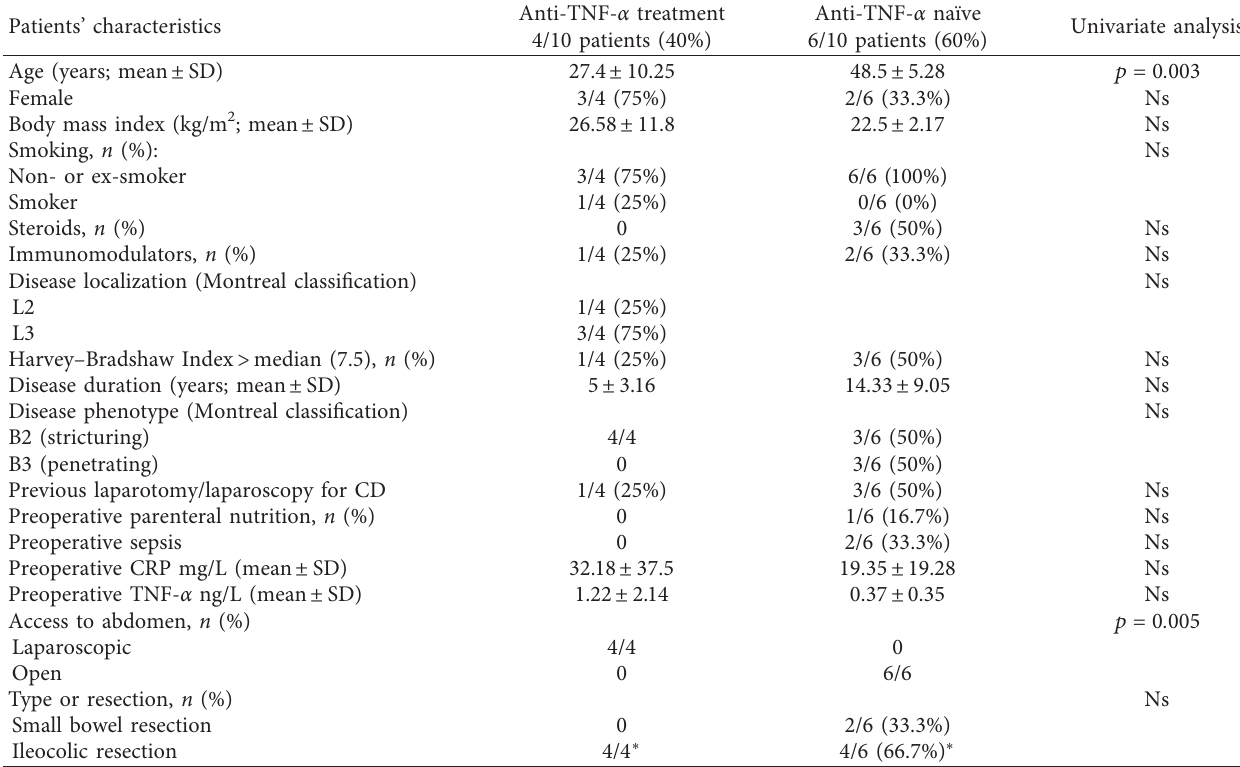
Table 1: Preoperative and intraoperative characteristics of 10 patients with Crohn’s disease treated with anti-TNF- α compared to anti-TNF- α na¨ıve patients.